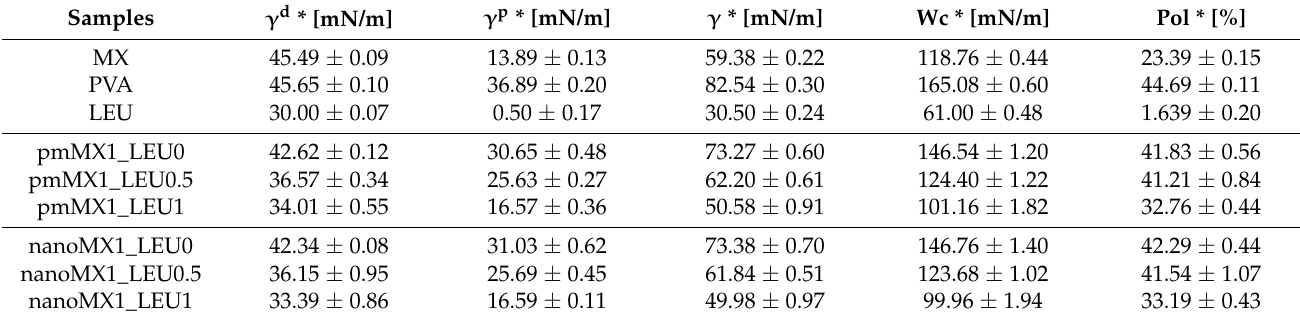
Table 7. Surface free energy, cohesion work, and polarity values of the samples and their